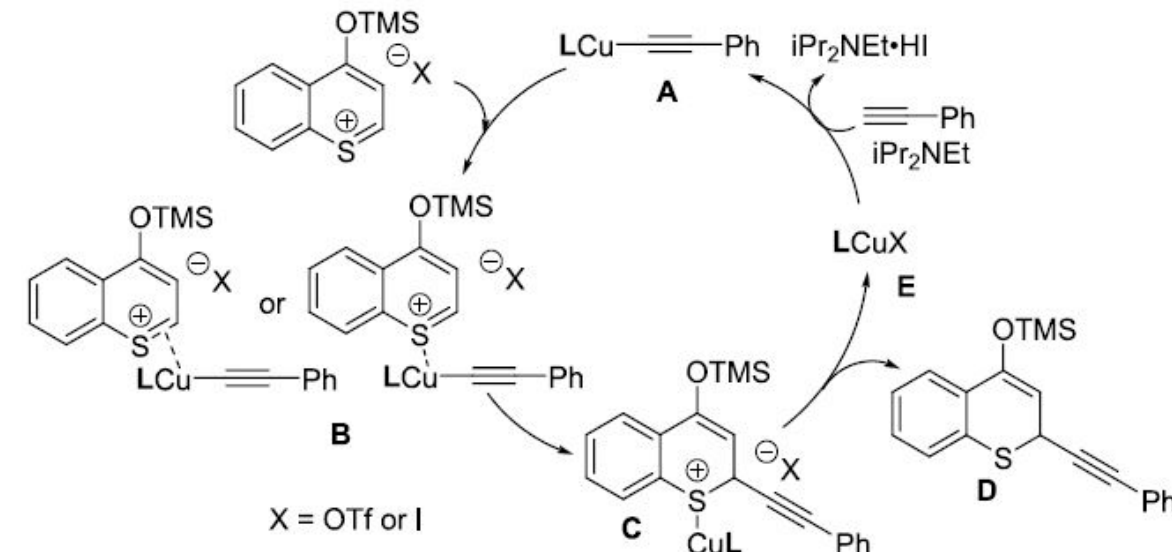
Figure 22. Mechanism of reaction of thioflavonoids as reported by Meng et al. [162]. Natural and synthetic chiral flavonoids presented in this review with the most promising antitumor activity are summarized in Table 2.